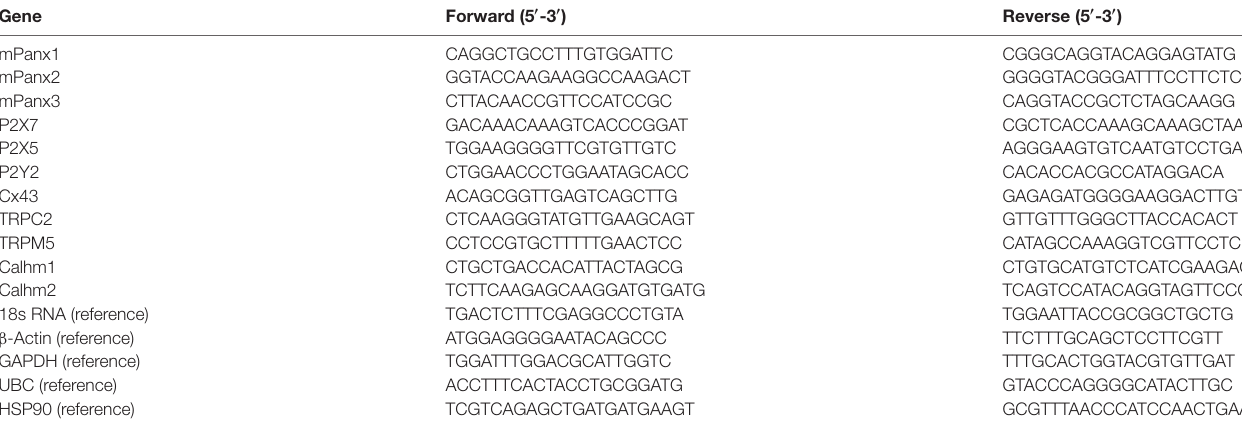
TABLE 1 | Primer pairs for quantitative Real Time-PCR (qRT-PCR). Gene Forward (5 (cid:48) -3 (cid:48) ) Reverse (5 (cid:48) -3 (cid:48) )